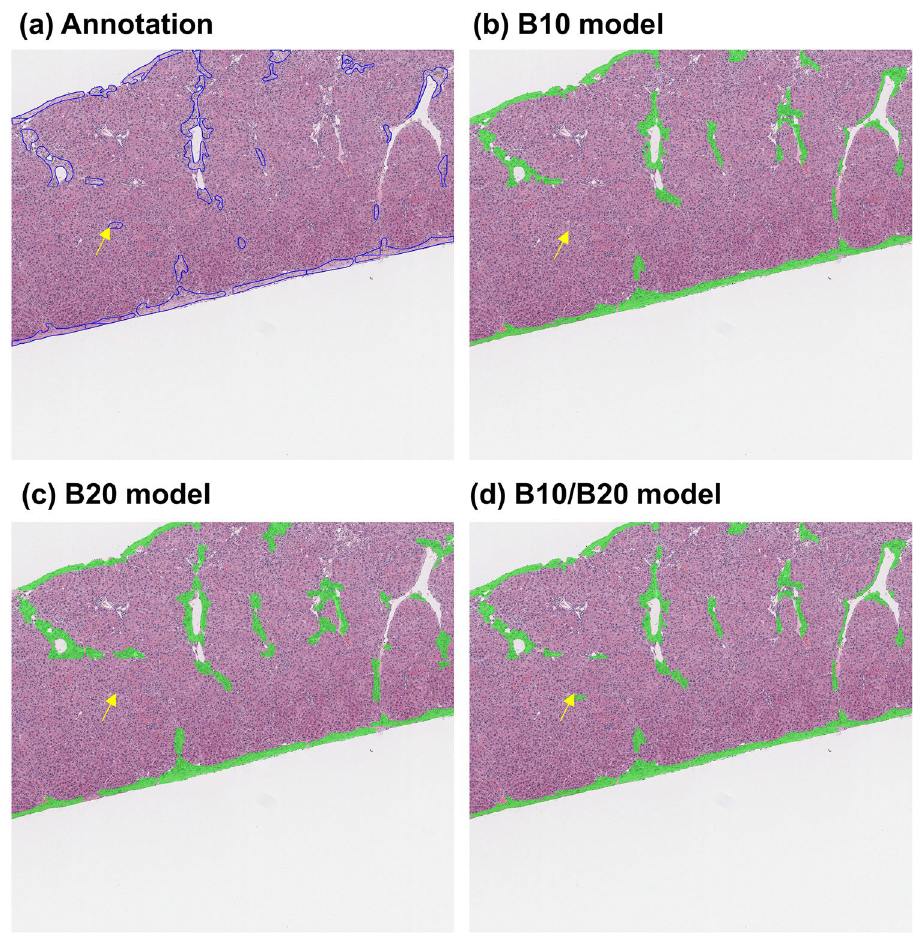
Figure 7. 2688 × 2688 pixels images of the model prediction results, according to each trained weight. ( a ) Ground truth annotation, (b)–(d) predicted lesion by each single dataset model and the B10/B20 mixed model. The yellow arrows point out the fibrosis lesion that only B10/B20 model could